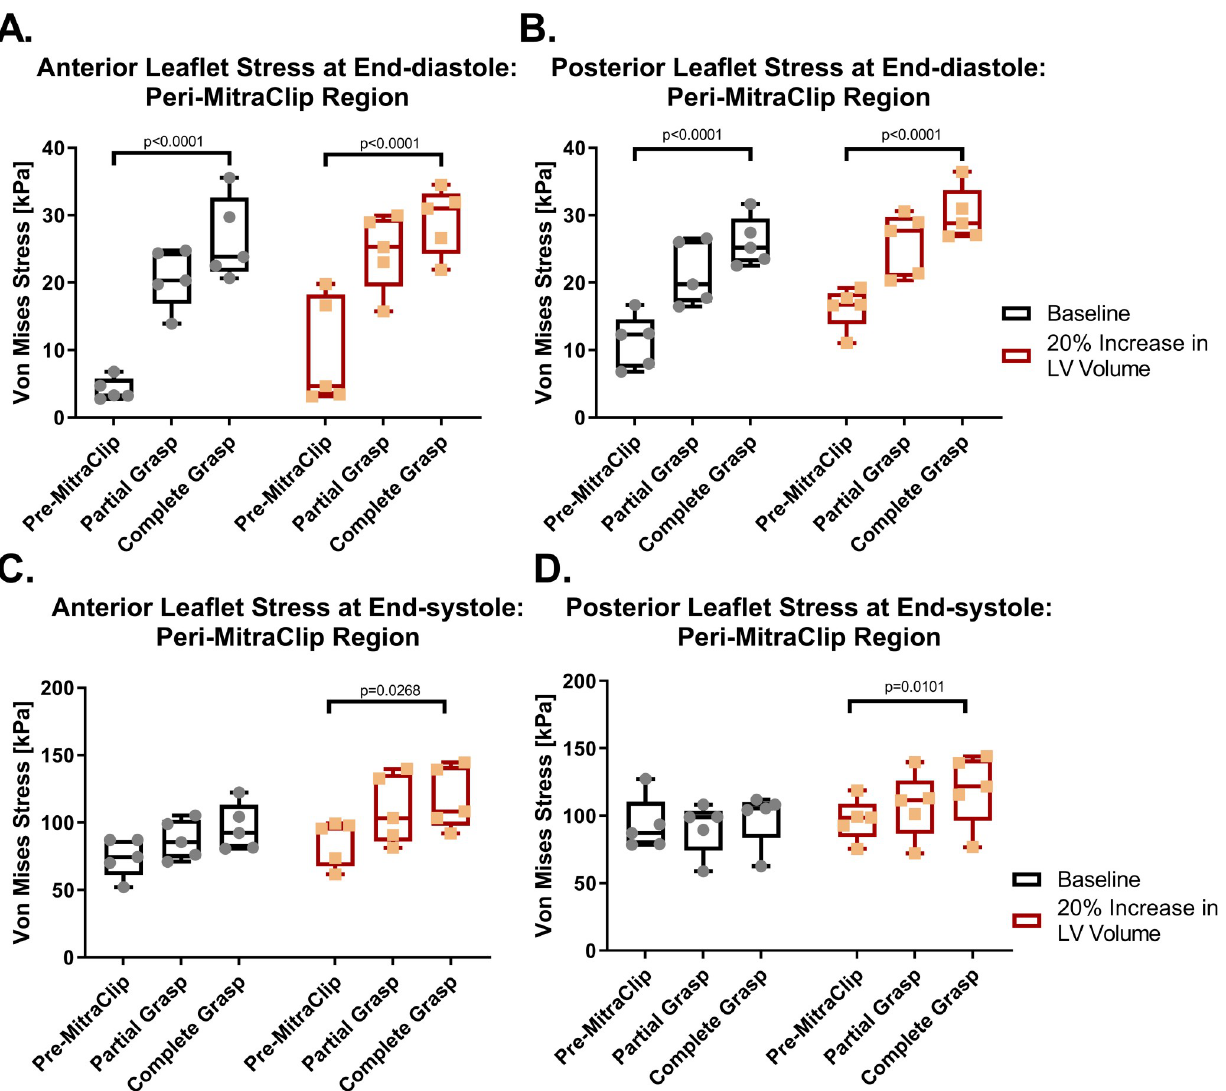
Fig 4. Stress in the peri-MitraClip region in the anterior and posterior leaflets at end-diastole (A and B) and end-systole (C and